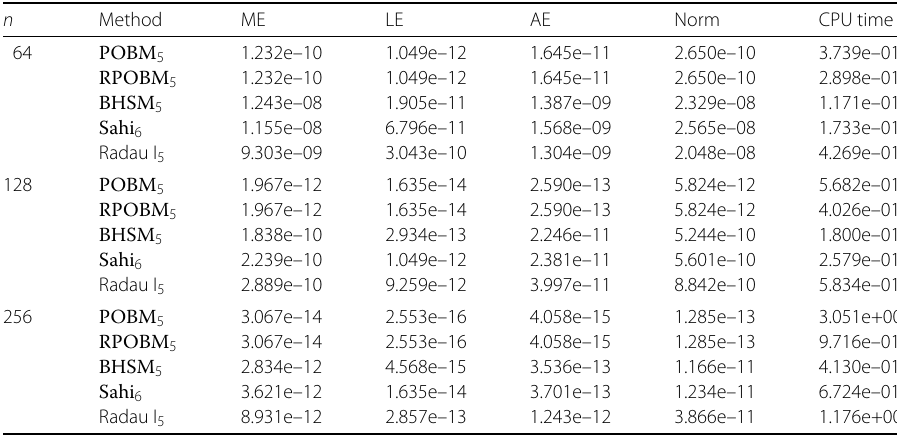
Table 1 Comparison of the methods under consideration on the basis of absolute errors and CPU time for the flame propagation model given in Problem 1 with different number of steps ( n ) n Method ME LE AE Norm CPU time 64 POBM